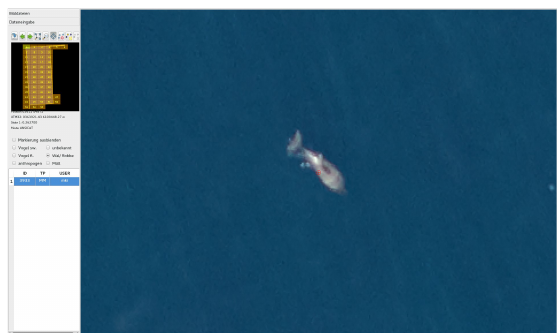
Figure 3. Screenshot of a software interface for the systematic visual screening of geo-referenced aerial photographs (example image shows a harbour porpoise)